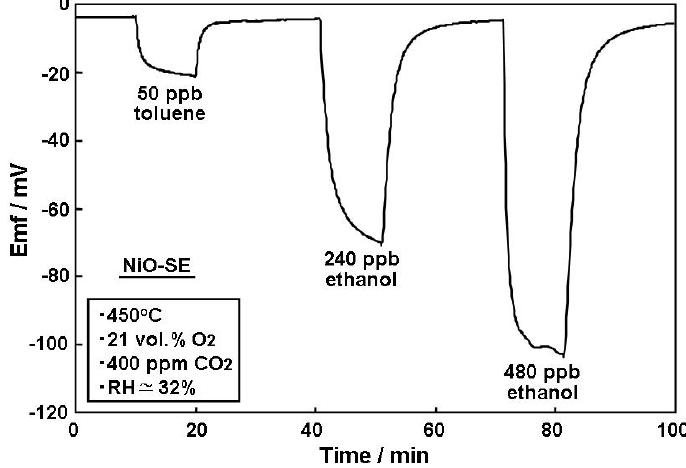
Figure 2. Response transients of YSZ-based sensor utilizing NiO-SE towards toluene and ethanol at an operational temperature of 450 °C under humid conditions (RH ⋍